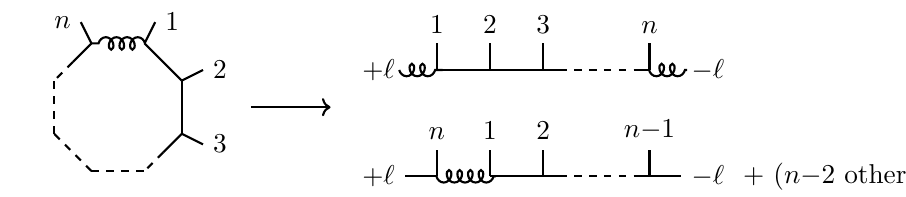
Figure 3 . In the partial-fraction decomposition of an n -gon diagram with one gluon propagator and otherwise scalar propagators, the associated tree-level diagrams describe one gluonic forward limit with internal scalars and n − 1 scalar forward limits with one internal gluon